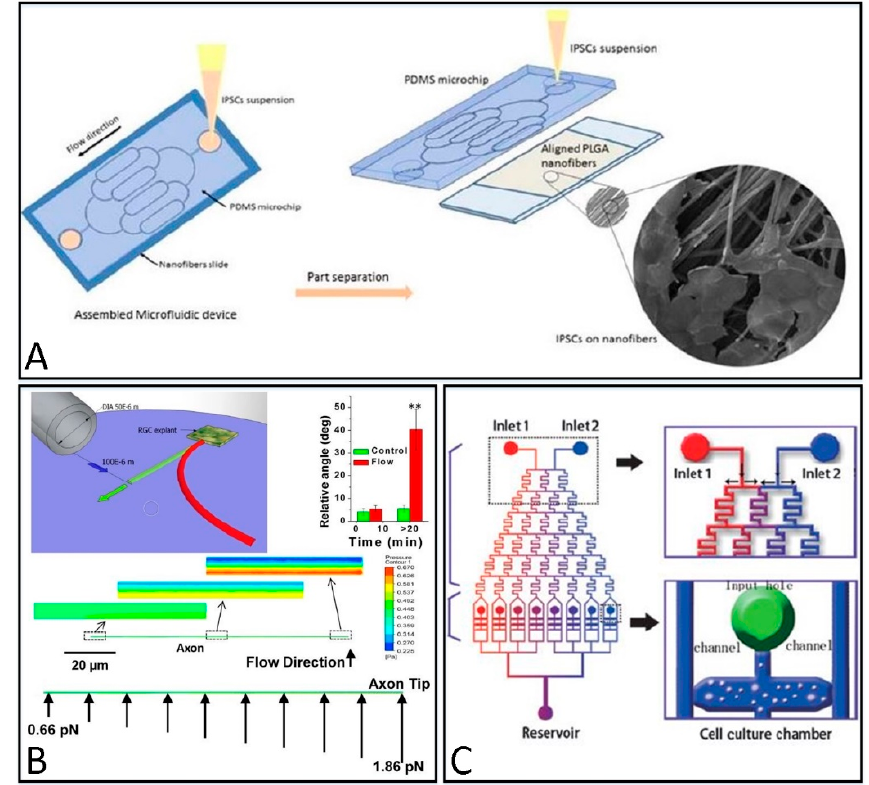
Figure 6. Axon guidance methods. ( A ) Topographical guidance microfluidic device using aligned PLGA nanofibers by Hesari, Z. ( B ) Mechanical guidance microfluidic device using steer force of adjustable flow to guide the orientation of growth cone designed by Gu, L. ( C ) Chemical gradients guidance microfluidic device using net transmission structure to generate solution concentration gradients by Yin, B. S.